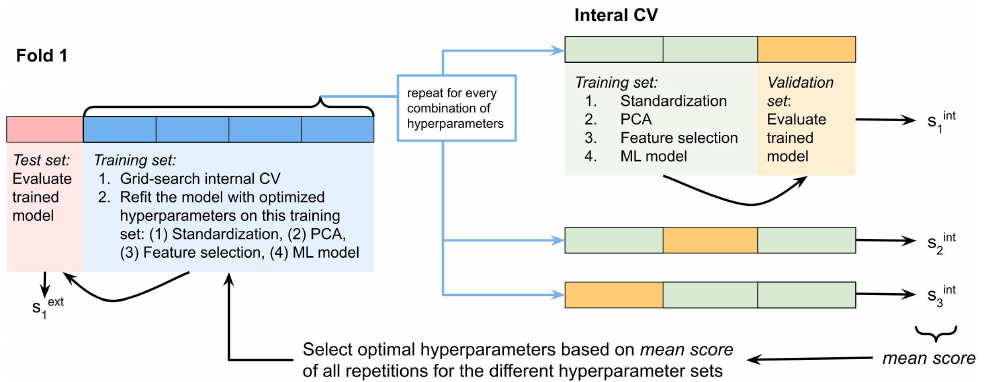
Figure 2. Visualization of a part of the model construction